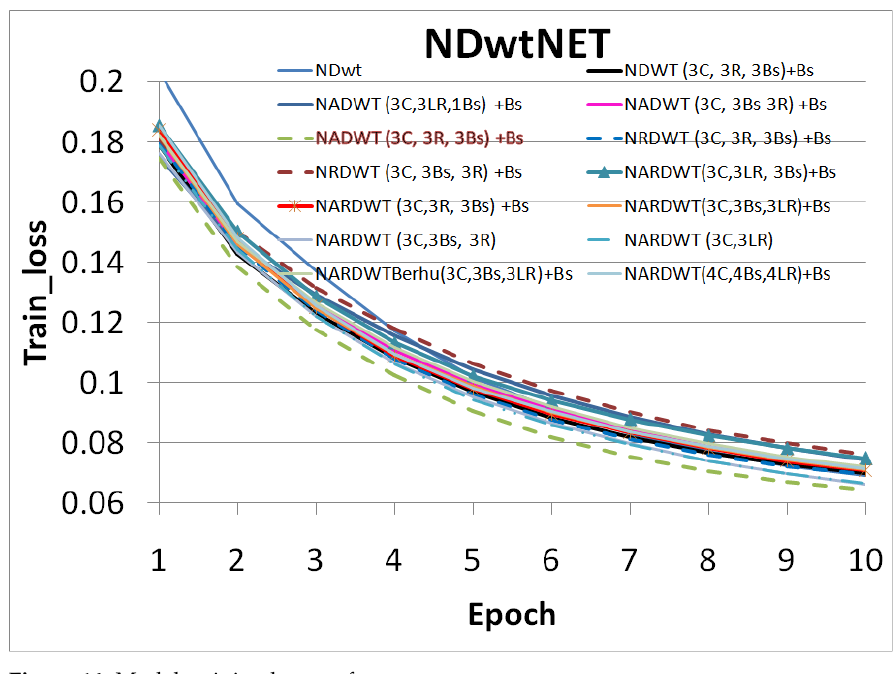
Figure 14. Model training loss performance.